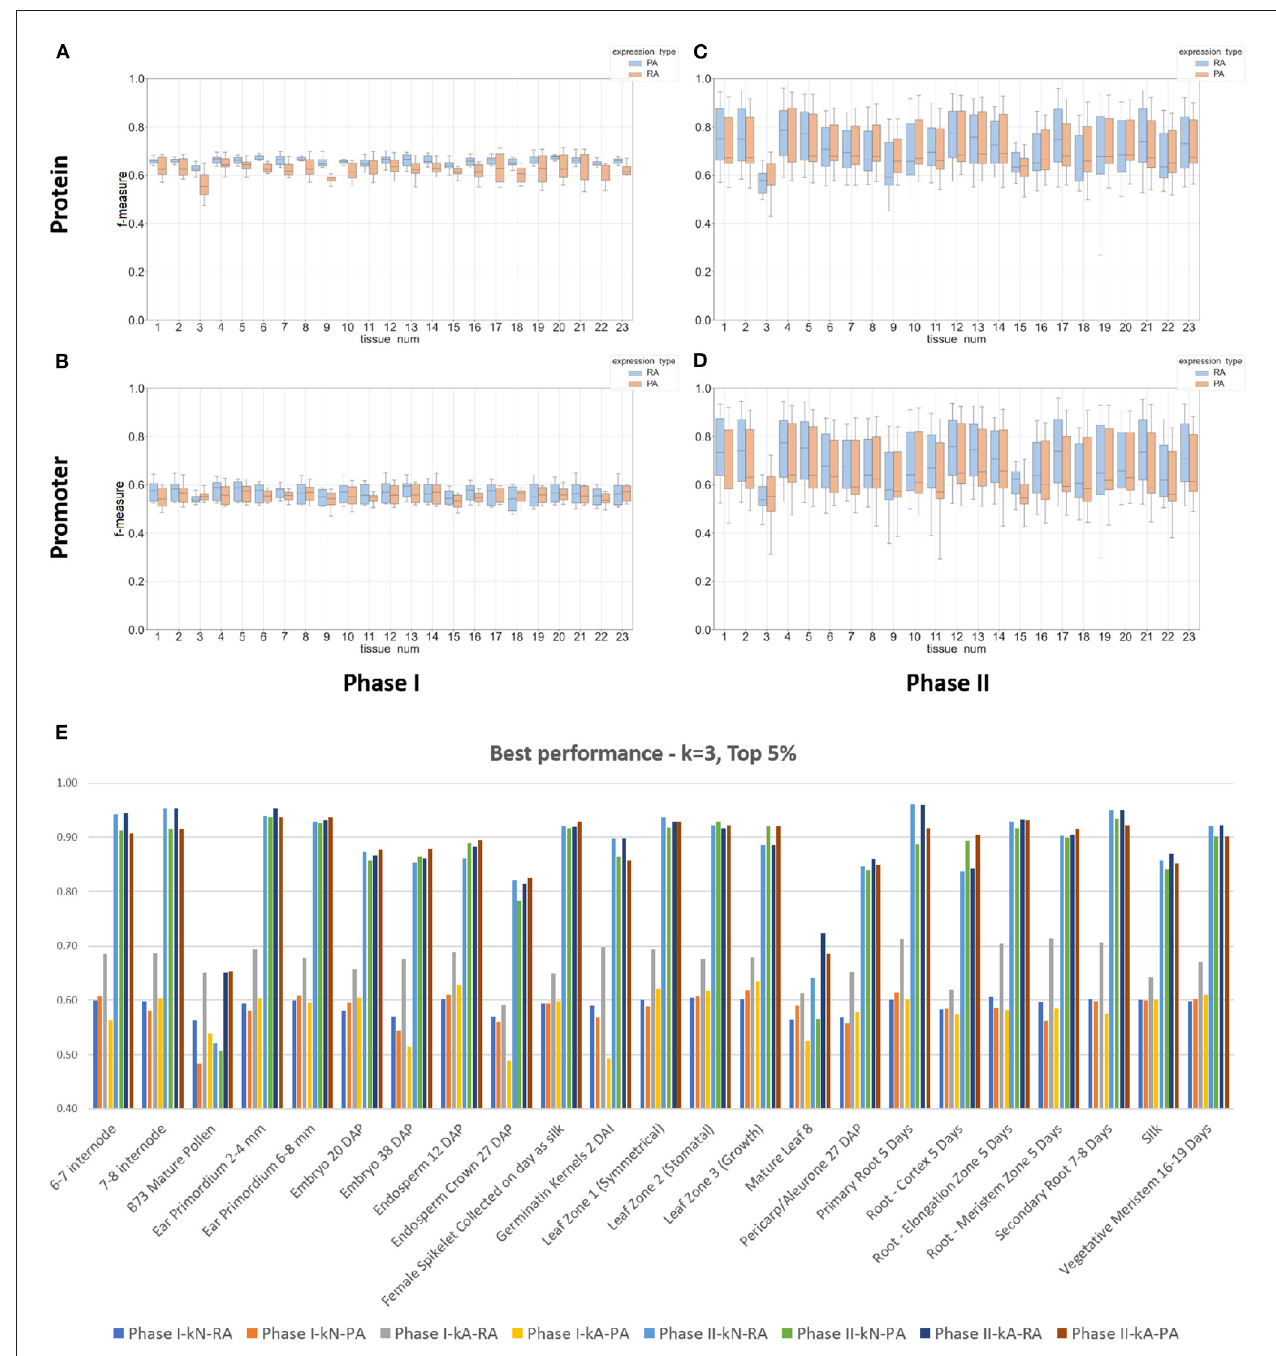
FIGURE 4 | Box plots and a histogram of the best performing Phase I and II classifiers across all experiments. The Phase II method is based on Bayesian Network. Each plot shows the interquartile range and mean of F-measures across the top 5–30% and bottom 5–30% of expression cutoffs. The k -mer size used was 3 for protein sequence (A,C) and 3 for DNA promoter sequence (B,D) . The x-axis is labeled by tissue type (see Table 1 or Panel (E) for a full list of tissue names). Panels (A,B) are plots based on the Phase I method and Panels (C,D) are based on the Phase II method. Individual dots are outliers that are outside 1.5 times the interquartile range above the upper quartile or below the lower quartile. Panel (E) is a histogram of the best performing classifiers based on a fixed k -mer size of 3 and expression cutoff of Top 5%. The x-axis is labeled by tissue type. Each tissue displays the f-measure of the eight experiments based on the combinations of method (Phase I or II), input type (DNA promoter or protein sequence), and output class (mRNA or protein